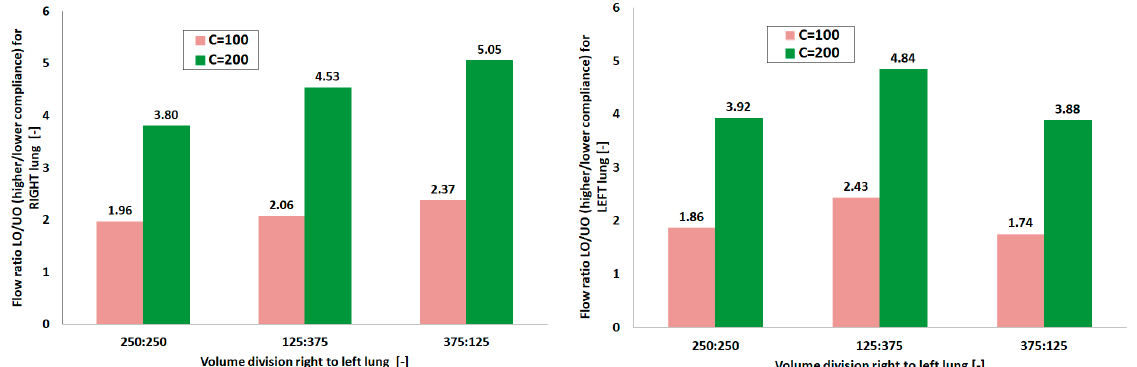
Figure 8. Flow distribution between branches with different compliances during ventilation for model lungs with different system compliances (C = 100 and 200 mL/cm H 2 O) for various tidal volume divisions (LO—branch with higher compliance; UO—branch with lower compliance).